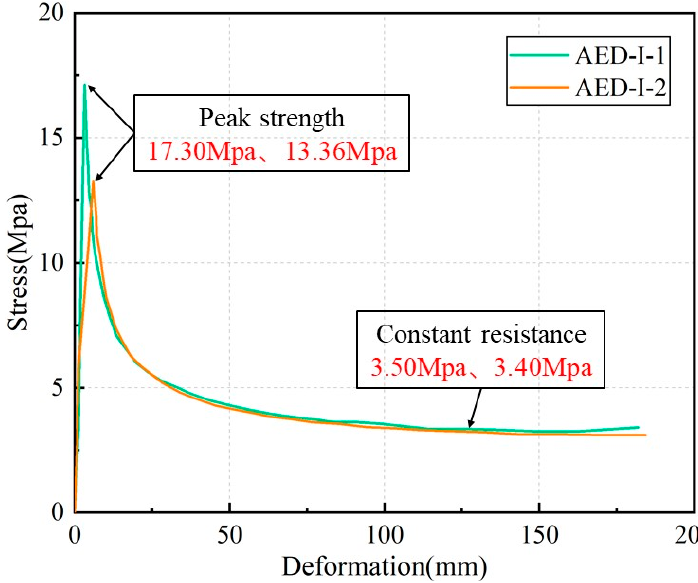
Figure 9. The stress–deformation curve of the AED-Is.